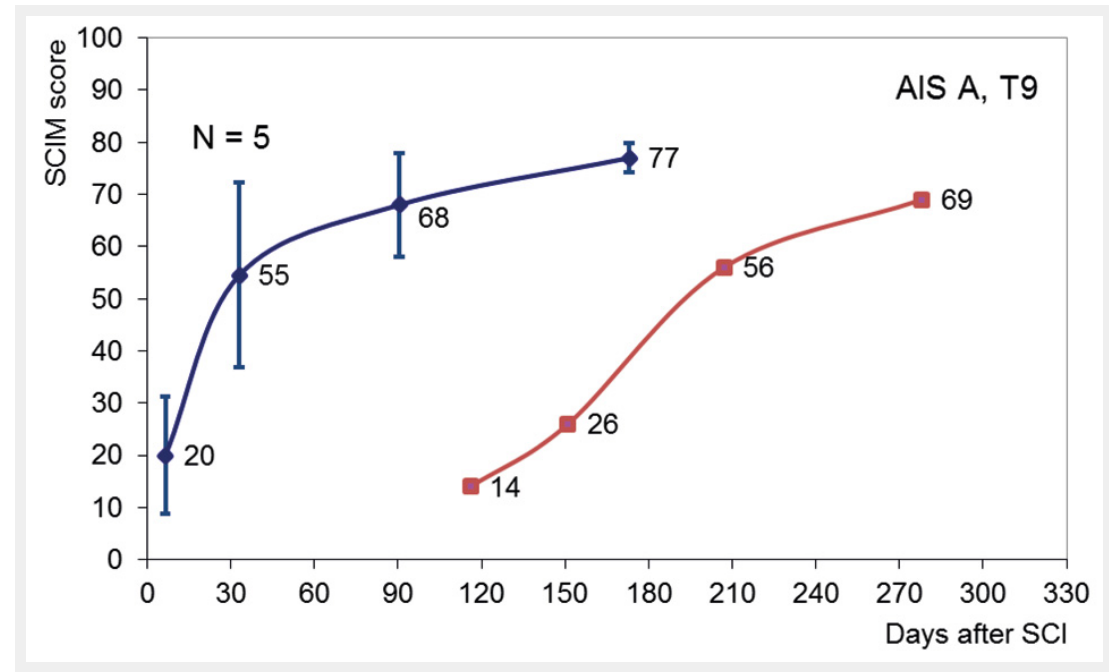
Figure 4 Delayed onset of rehabilitation. Improvement in Spinal Cord Independence Measure (SCIM) scores from a patient with a sensory motor complete (AIS A) lesion at thoracic 9 (T9), who entered rehabilitation with an almost 4 month delay in onset (red line). Averaged improvements in SCIM score (with SD) of 5 patients matched for severity and level of lesion (blue line). The results indicate that without rehabilitation, spontaneous improvement in activities of daily life is